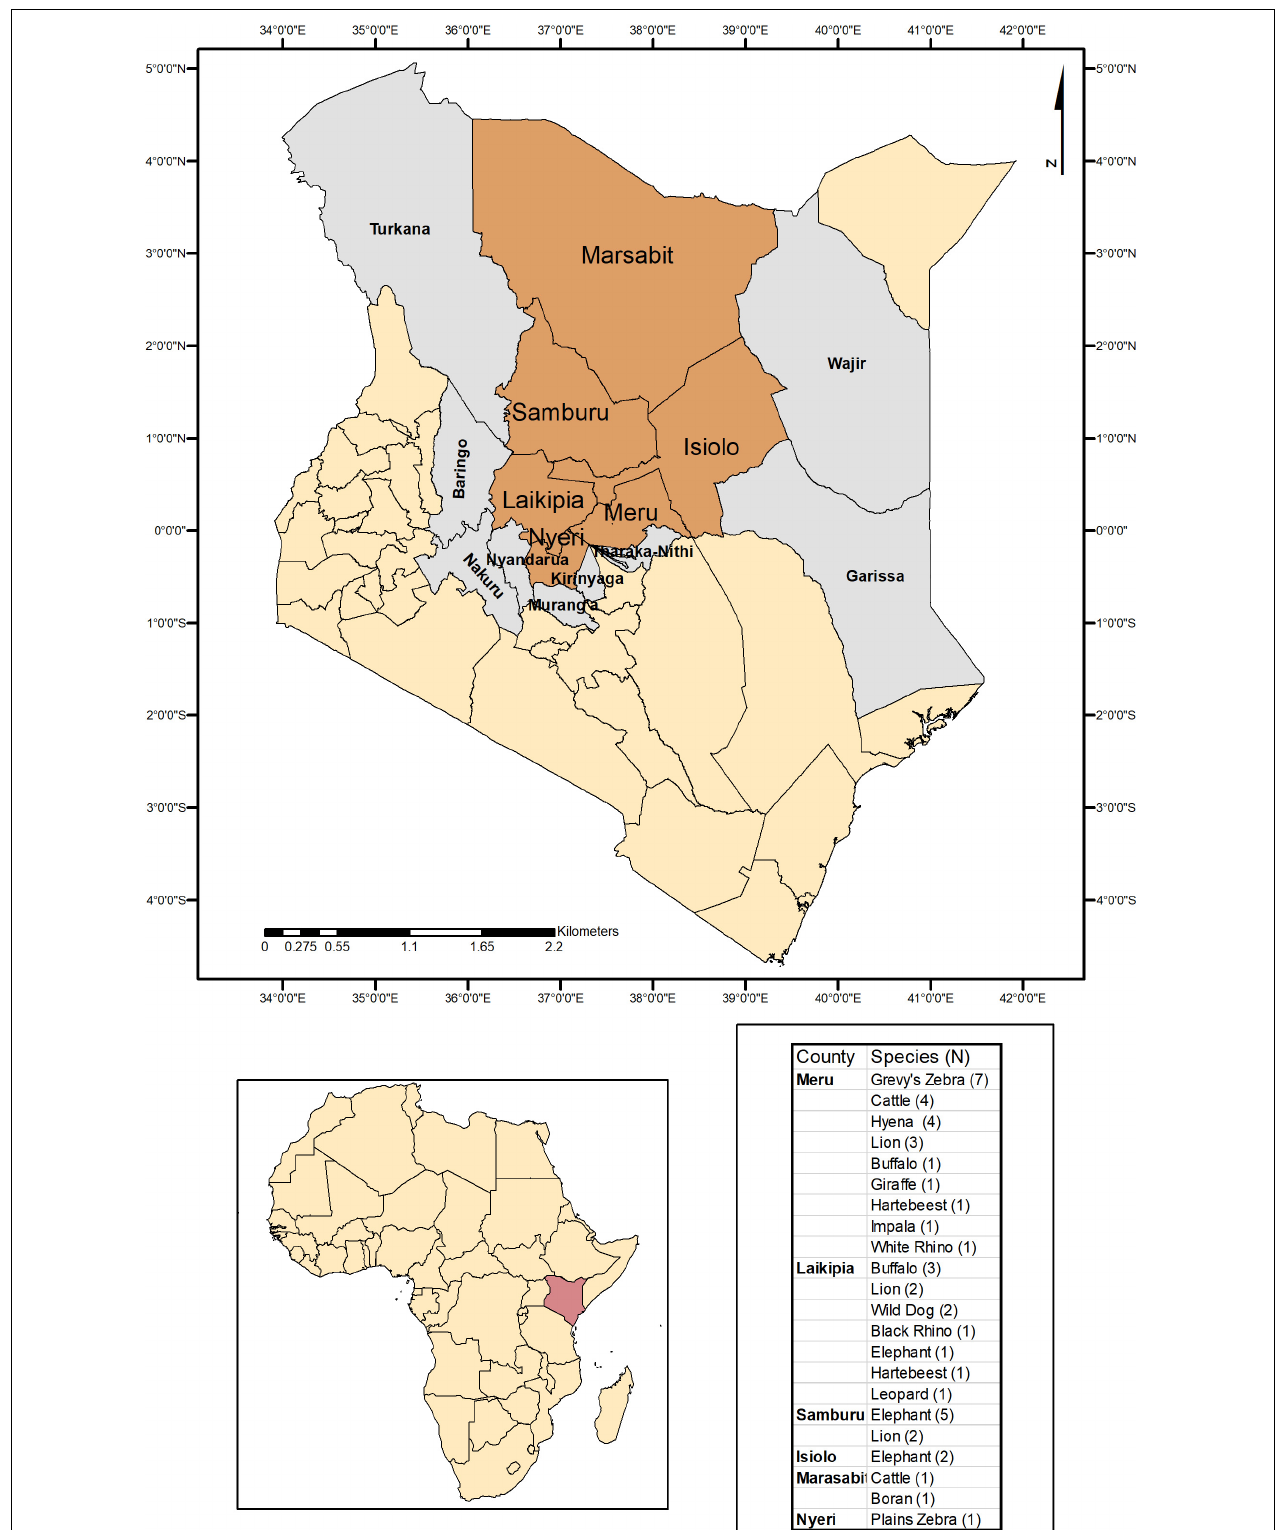
FIGURE 1 | Map indicating the counties where ticks were collected and sampled when feeding on domestic and wild animals in Kenya.